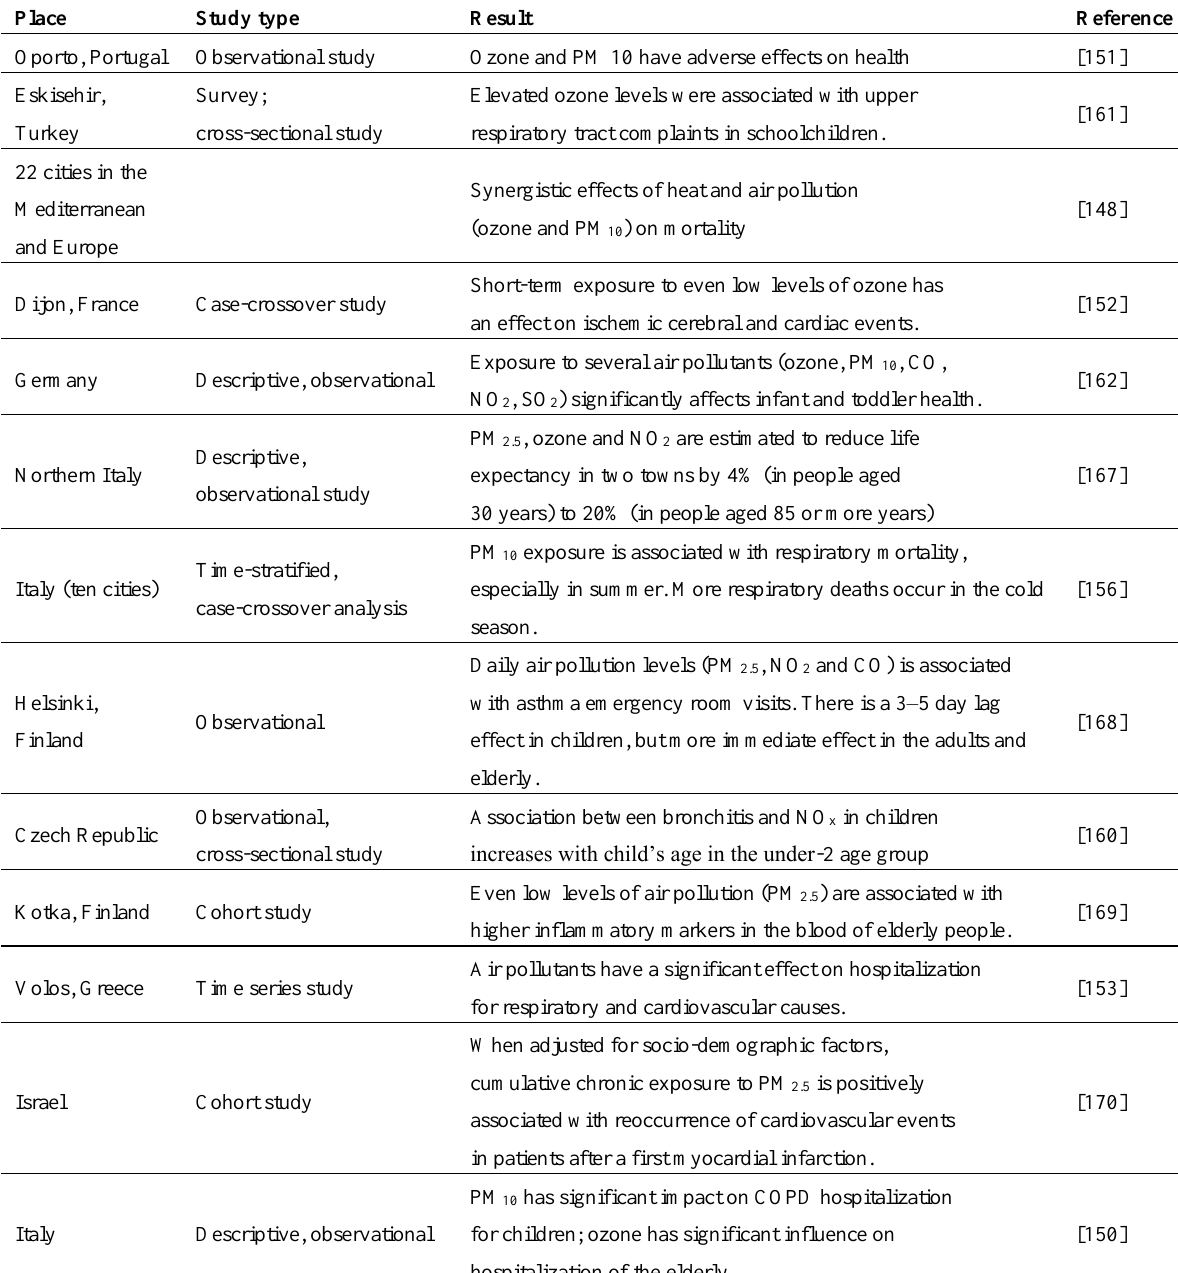
Table 9. Search results of literature about climate change, air quality and health